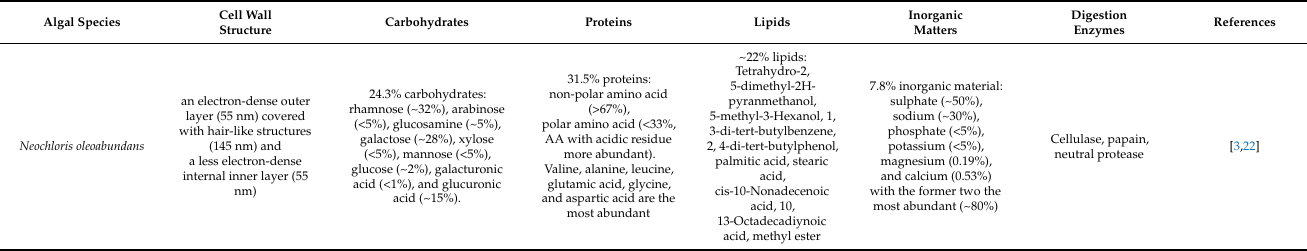
Table 1. Chemical compositions and structures of Chlorophyta cell